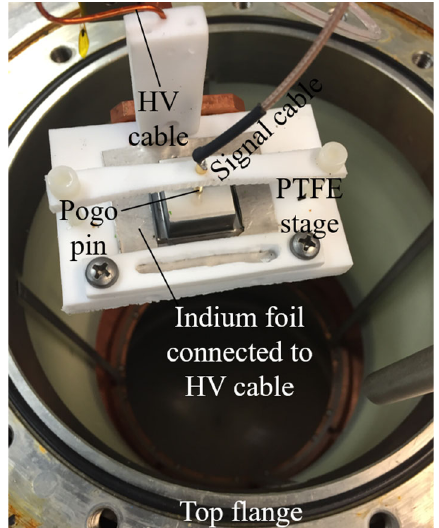
Fig. 7 Detector to be lowered into the MPI cryostat